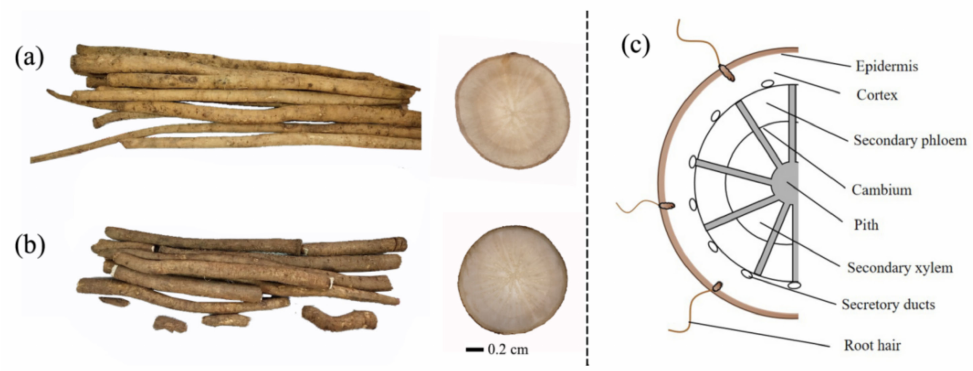
Figure 2. Images and structures of A. lappa roots . Fresh A. lappa roots and sections cut in Baiji variety ( a ) and Yanagawa-riso variety ( b ), Author’s collection; and tissue structure ( c ). Adapted from [26], with permission from Elsevier Ltd, 2020.